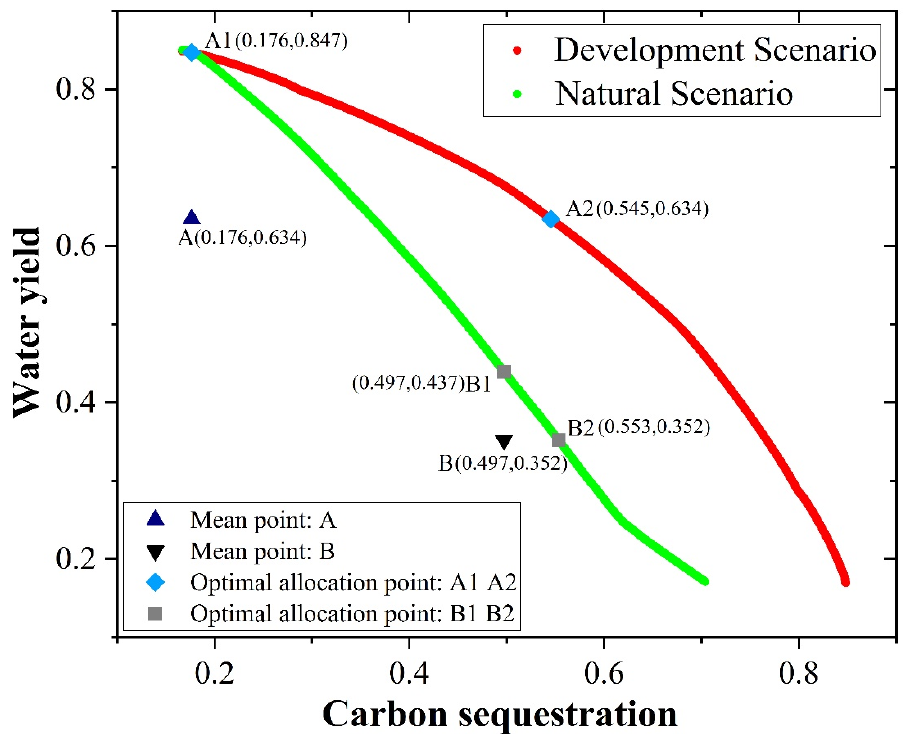
Figure 8. Trade-off curve between water yield and carbon storage under different scenarios.